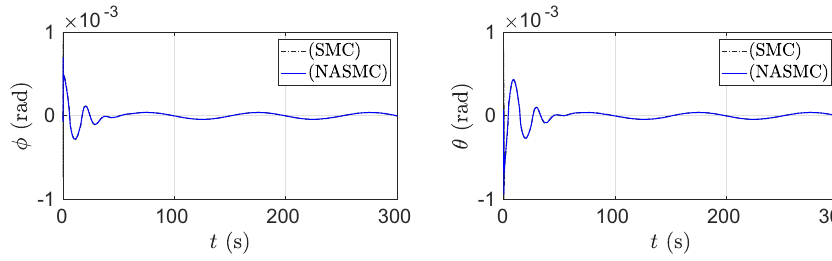
Figure 7: Roll and pitch angles of the quadcopter system using SMC and NASMC.